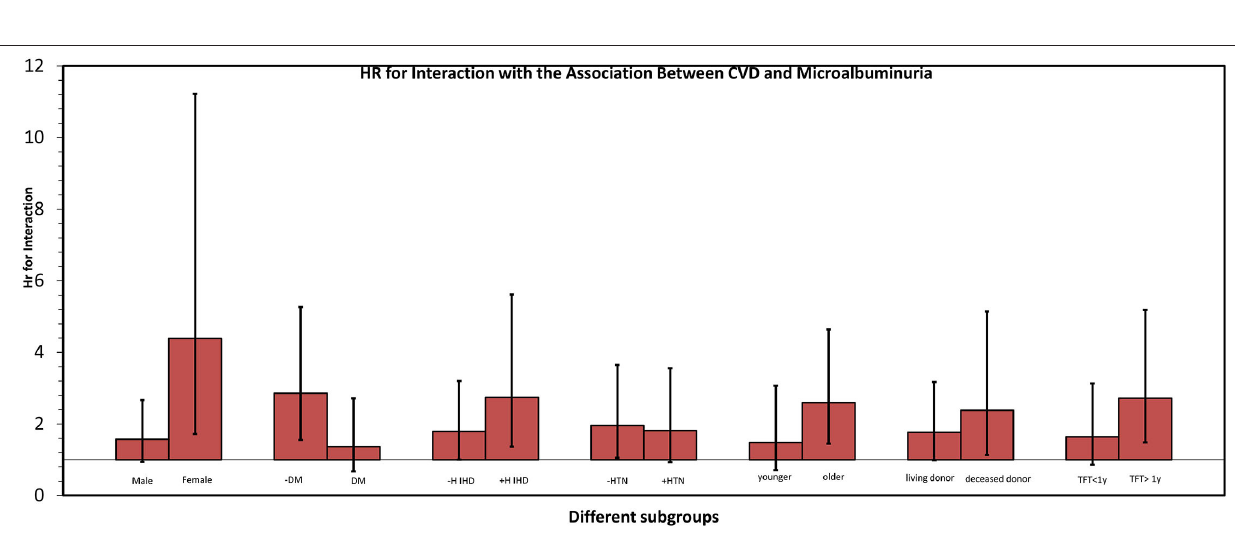
Frontiers in Medicine |